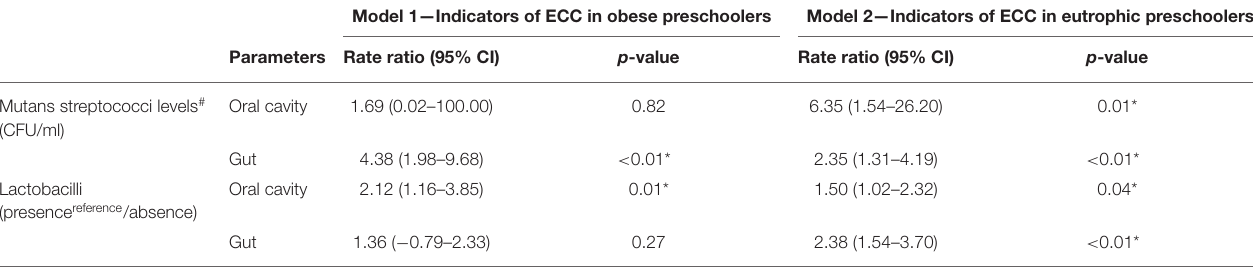
Poisson regression model; main outcome: early childhood caries (number of decayed, missing, or filled surfaces of the teeth). * Statistically significant at p < 0.05. CI, confidence interval. Model 1 (n = 36): Omnibus test: likelihood ratio chi-square = 15.99, freedom degree 4, significance 0.003; Model 2 (n = 42): Omnibus test: likelihood ratio chi-square = 40.82, freedom degree 4, significance 0.000. # MS levels were adjusted by dividing them by the total microorganism levels. Rate ratio was considered as a measure of effect size: 1.22 (small), 1.86 (medium), 3.00 (large) (28).